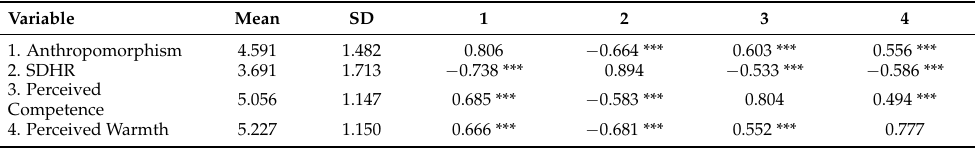
Table 4. The mean, standard deviation, correlation coefficient, and AVE’s square